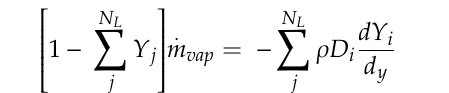
Table 1. Boundary conditions and turbulence models.